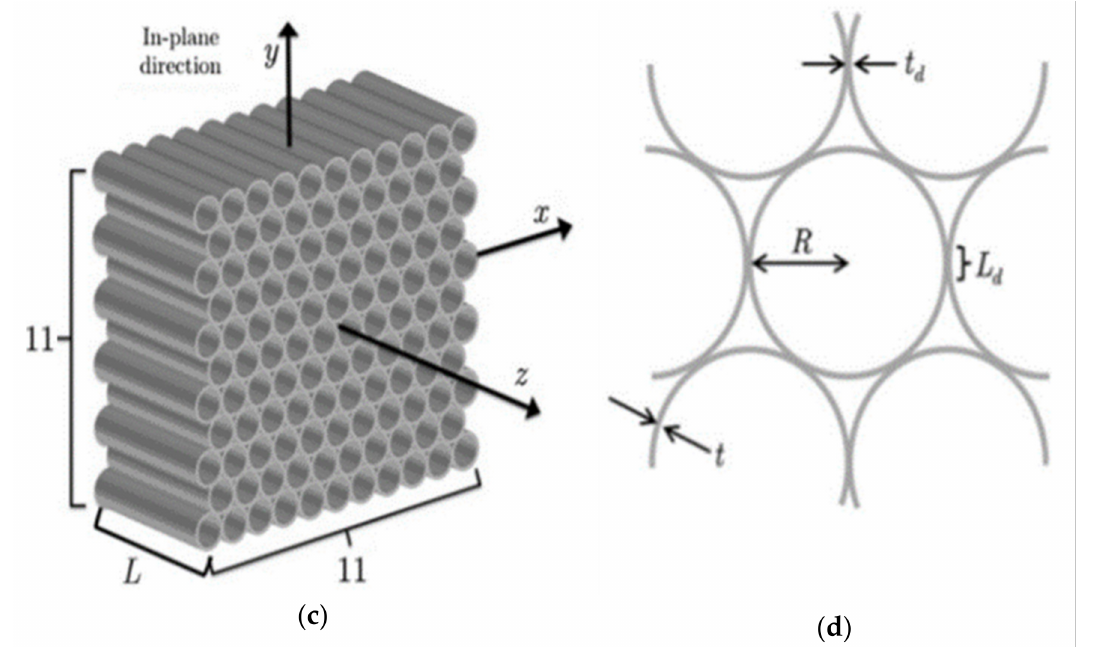
Figure 7. ( a ) Photograph of mold used to fabricate the GFRP core; ( b ) Profile of the cross-section of a GFRP core; [55] ( c ) Sketch of a 11 × 11 size circular cell honeycomb; ( d ) Details of the microsection with relevant dimensions, R: cell radius, t: wall thickness, L: cell length, td: double-wall thickness, L d : bond length (right)